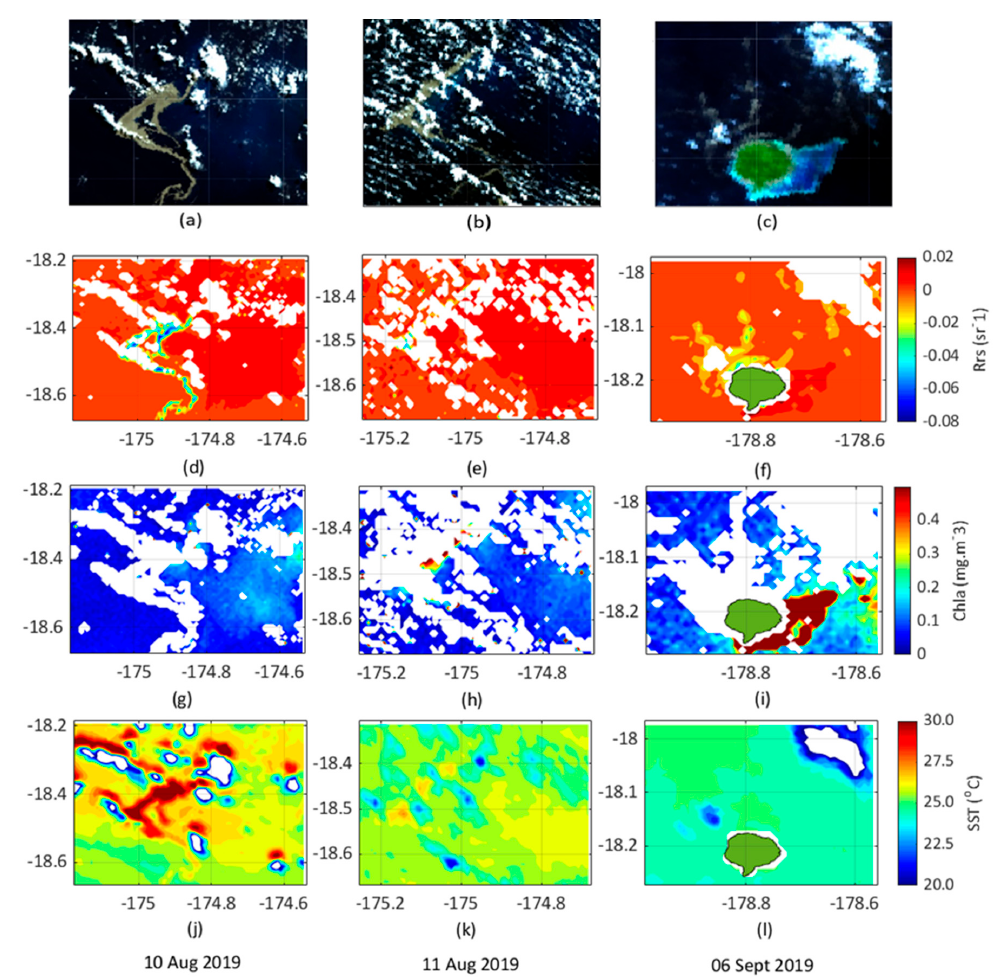
Figure 7. Sentinel-3 OLCI L2 Water Surface Reflectance at Full Resolution (WFR) images for 10–11 August and 6 September 2019: ( a-c ) true color (RGB) extracted from Level 1B processing, and Level 2 data for: ( d-f ) Rrs at 442.5 nm, ( g-i ) chlorophyll-a concentration, and ( j-l ) sea surface temperatures. NAN values are shown in white in Rrs, Chla, and SST images. Rrs values at 442.5 nm were retrieved by dividing Oa3 reflectance (water-leaving radiance) values by π .